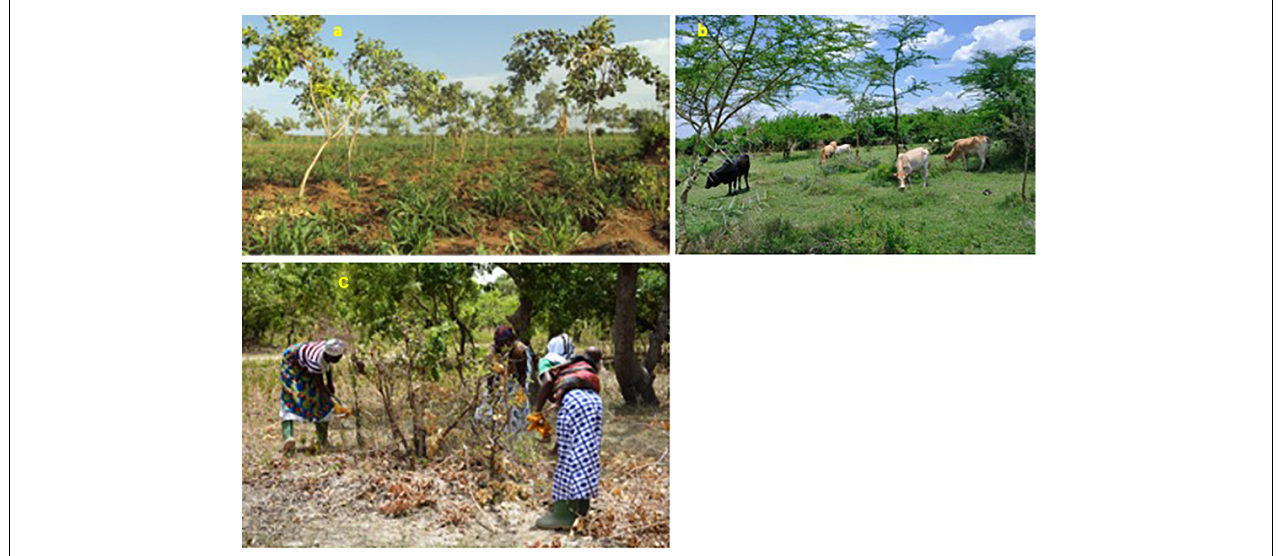
FIGURE 2 | Pictures from the field illustrating the practice of Farmer Managed Natural Regeneration. (A) Shows young regeneration of Ziziphus Mauritania integrated with crops in Niger to boost soil fertility and improve crop production (photo by Patrice Savadogo). (B) Livestock grazing on an FMNR plot with acacia spp. in Kenya (photo by May Muthuri). (C) Female farmers thinning and pruning Combretum spp. to enhance growth of fewer but stronger stems in Ghana (photo by May